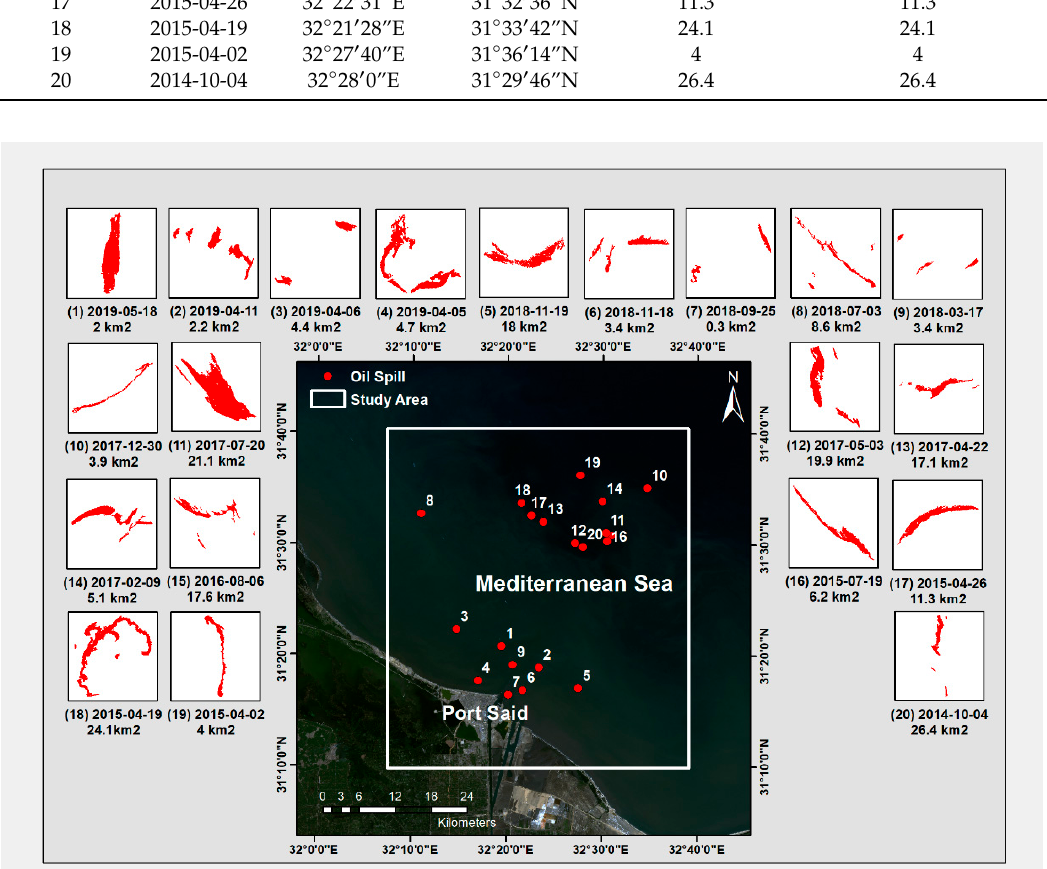
Figure 7. Oil spill accidents within the period 2014-2019. Table 2. Statistics of oil spill events within the period 2014-2019.